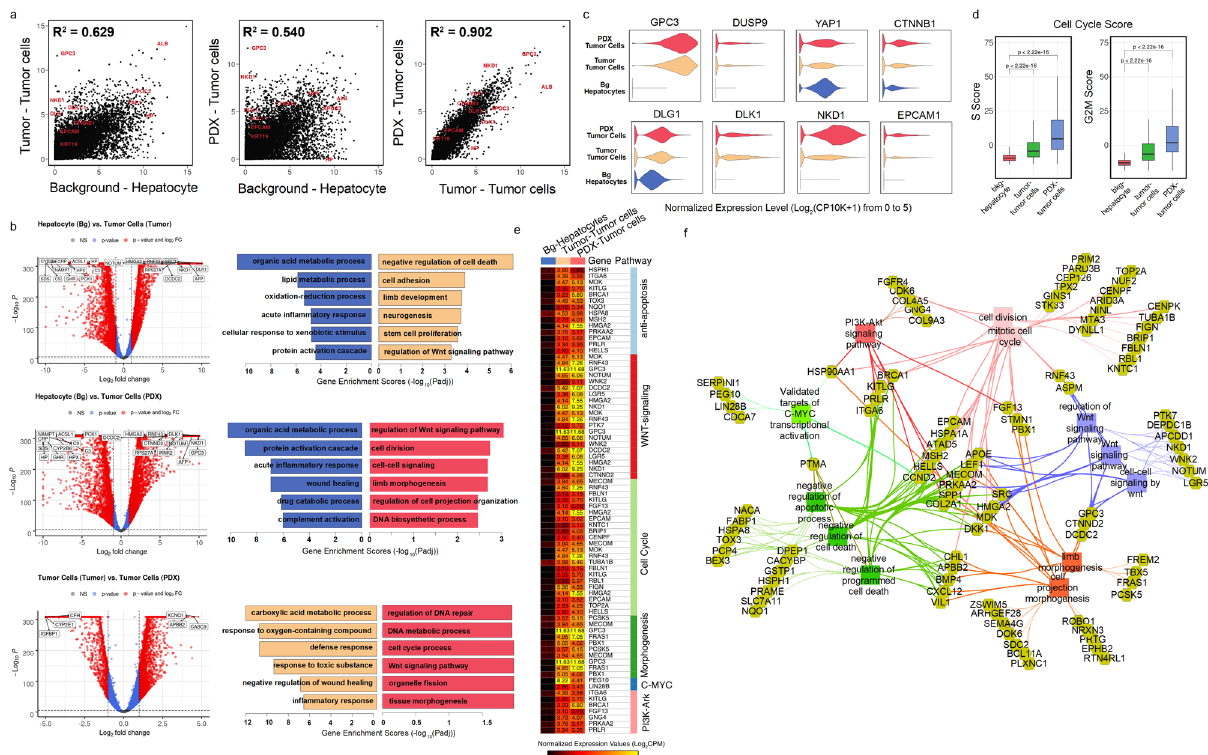
Fig. 4 Maintenance of features across the tumor and PDX. a Scatter plots for normalized expression values of all detected genes in hepatocytes of background liver versus tumor cells of tumor (Left), hepatocyte of background liver versus tumor cells of PDX (Middle), and tumor cells of tumor versus tumor cells of PDX (Right). R-square values were calculated after fi tting data into linear-regression models. Some markers of tumor cell and hepatocytes are highlighted. b Volcano plots (Left) and gene enrichment results for top 200 DEGs (Right) of comparisons in (A). Representative enriched pathways were shown, and gene enrichment scores were calculated using − Log 10 (adjusted enrichment p value). c Violin plots showed distributions of normalized expression levels of several important tumor genes across background hepatocytes and tumor cells in tumor and PDX. d Cell cycle scores, including scores of phase S (Left) and G2M (Right) of three main cell types showed that tumor cells had signi fi cantly higher proliferation activities. e Genes involved in the upregulated pathways of tumor cells in (B) were shown on the heatmap (Table S5). Normalized expression values were used. f Functional association network showing upregulated genes of tumor cells in HB T and PDX and their associations with tumor development-related pathways in (b and e) using ToppCluster